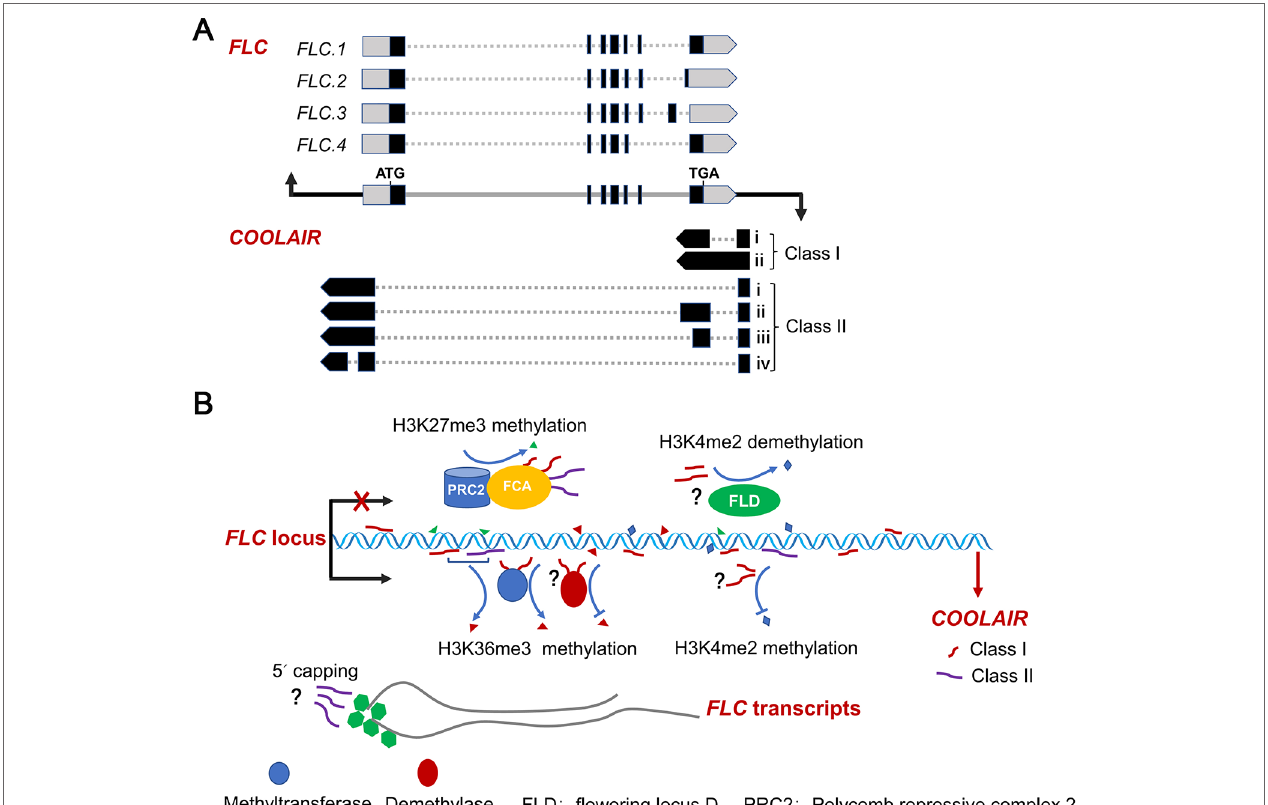
FIGURe 1 | Splicing patterns of FLC sense and antisense transcripts, and AS of FLC antisense transcripts regulating FLC expression. (A) Schematic diagram of the splicing patterns of FLC sense and antisense transcripts at FLC locus in Arabidopsis . Black rectangles, gray dash lines and boxes indicate exons, introns and non- translated regions of FLC RNAs, respectively. Gray and black lines represent the genes and promoter regions of FLC and COOLAIR loci, respectively. (B) AS variants of COOLAIR transcripts effect FLC expression. Nascent COOLAIR RNAs are physically associated with the FLC locus to regulate the switching of chromatin states (Csorba et al., 2014; Li et al., 2015; Rosa et al., 2016). Two classes of COOLAIR transcripts bind to FCA and recruit PRC2 complex to FLC locus (Tian et al., 2019). The class I variants with proximal polyadenylation and the proximal–distal ratio of COOLAIR transcripts effect the histone methylation of H3K4me2, H3K36me3 and H3K27me3 (Marquardt et al., 2014; Berry and Dean, 2015; Xiao et al., 2015; Rosa et al., 2016). The class II COOLAIR transcripts with distal polyadenylation influence the degree of capping of the FLC nascent transcripts (Li et al.,